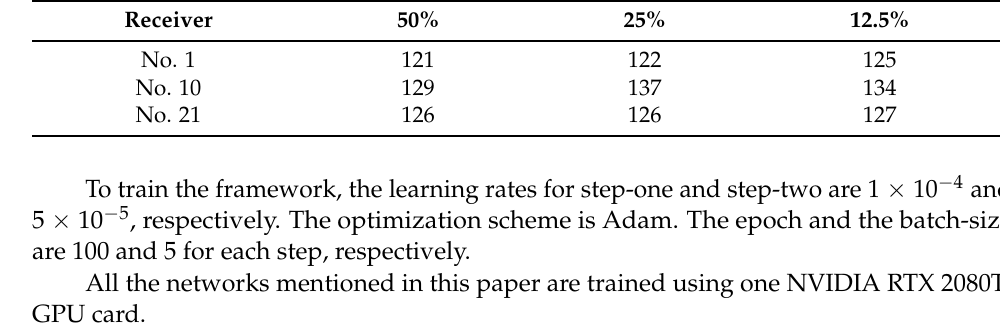
Table 1. Number of selected features among different receivers.